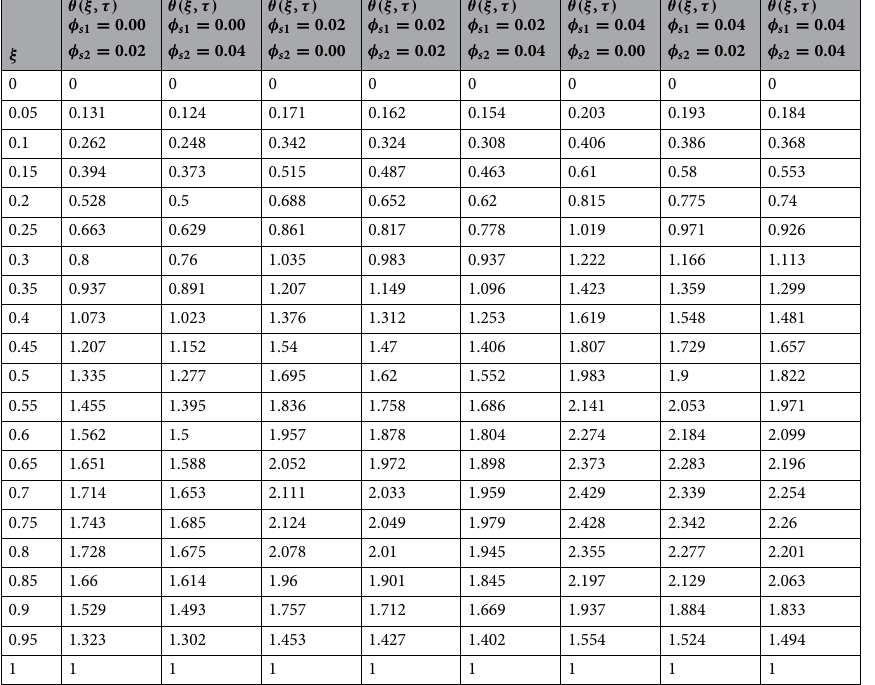
Table 6. Variations in temperature profile for various values of volume fraction of hybrid nanoparticles (Clay nanoparticles and